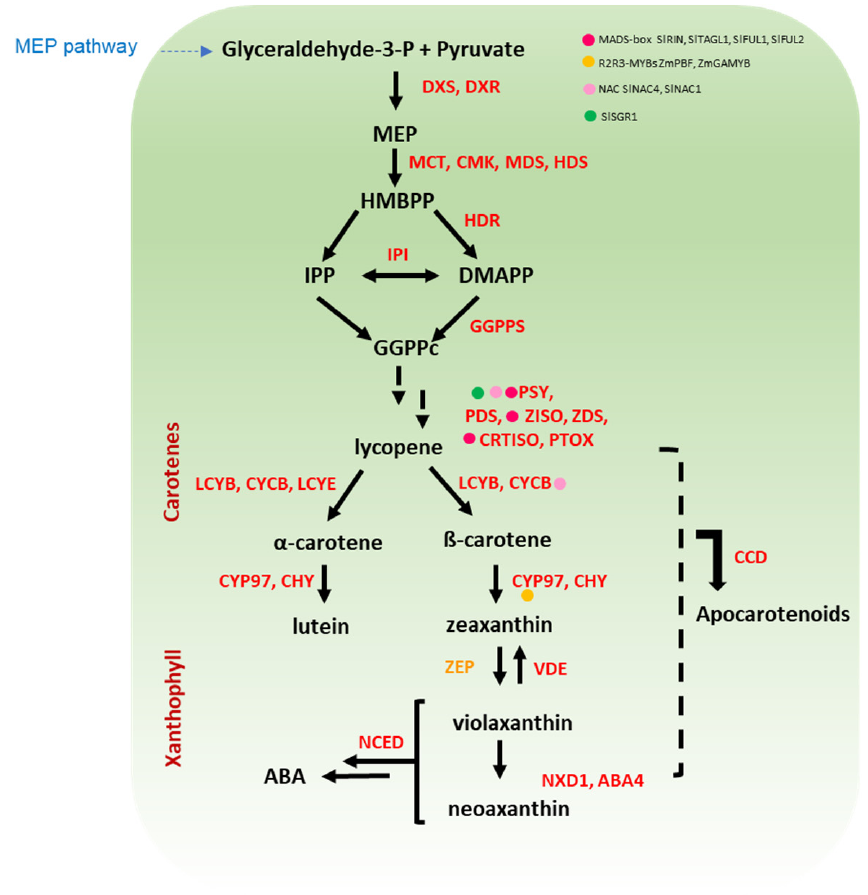
Figure 2. A simplified overview of carotenoid pathway in cereal and Solanaceae crops. The first step in carotenoid biosynthesis is the condensation of two GGPP molecules to form phytoene catalysed by PSY , which is the main rate-limiting step in solanaceous fruits and cereal grains. Further, the conversion of phytoene to lycopene via sequential desaturation and isomerization reactions is catalysed by a set of four enzymes (PDS, ZISO, ZDS, and CRTISO). Lycopene is at the branch point of carotenoid synthesis since it can be cyclized to ß-carotene or α -carotene by LCYB and LCYE. Downstream, the sequential hydroxylation and epoxidation of these carotenes leads to the production of diverse xanthophylls (e.g., lutein and zeaxanthin). Regulatory proteins belonging to diverse classes of transcription factors are marked with coloured dots. The name of the enzymes is detailed in the abbreviation list.